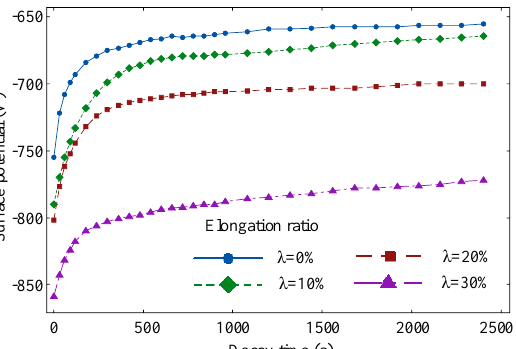
Figure 7. Electrical conductivity of polyethylene at different elongation ratios.